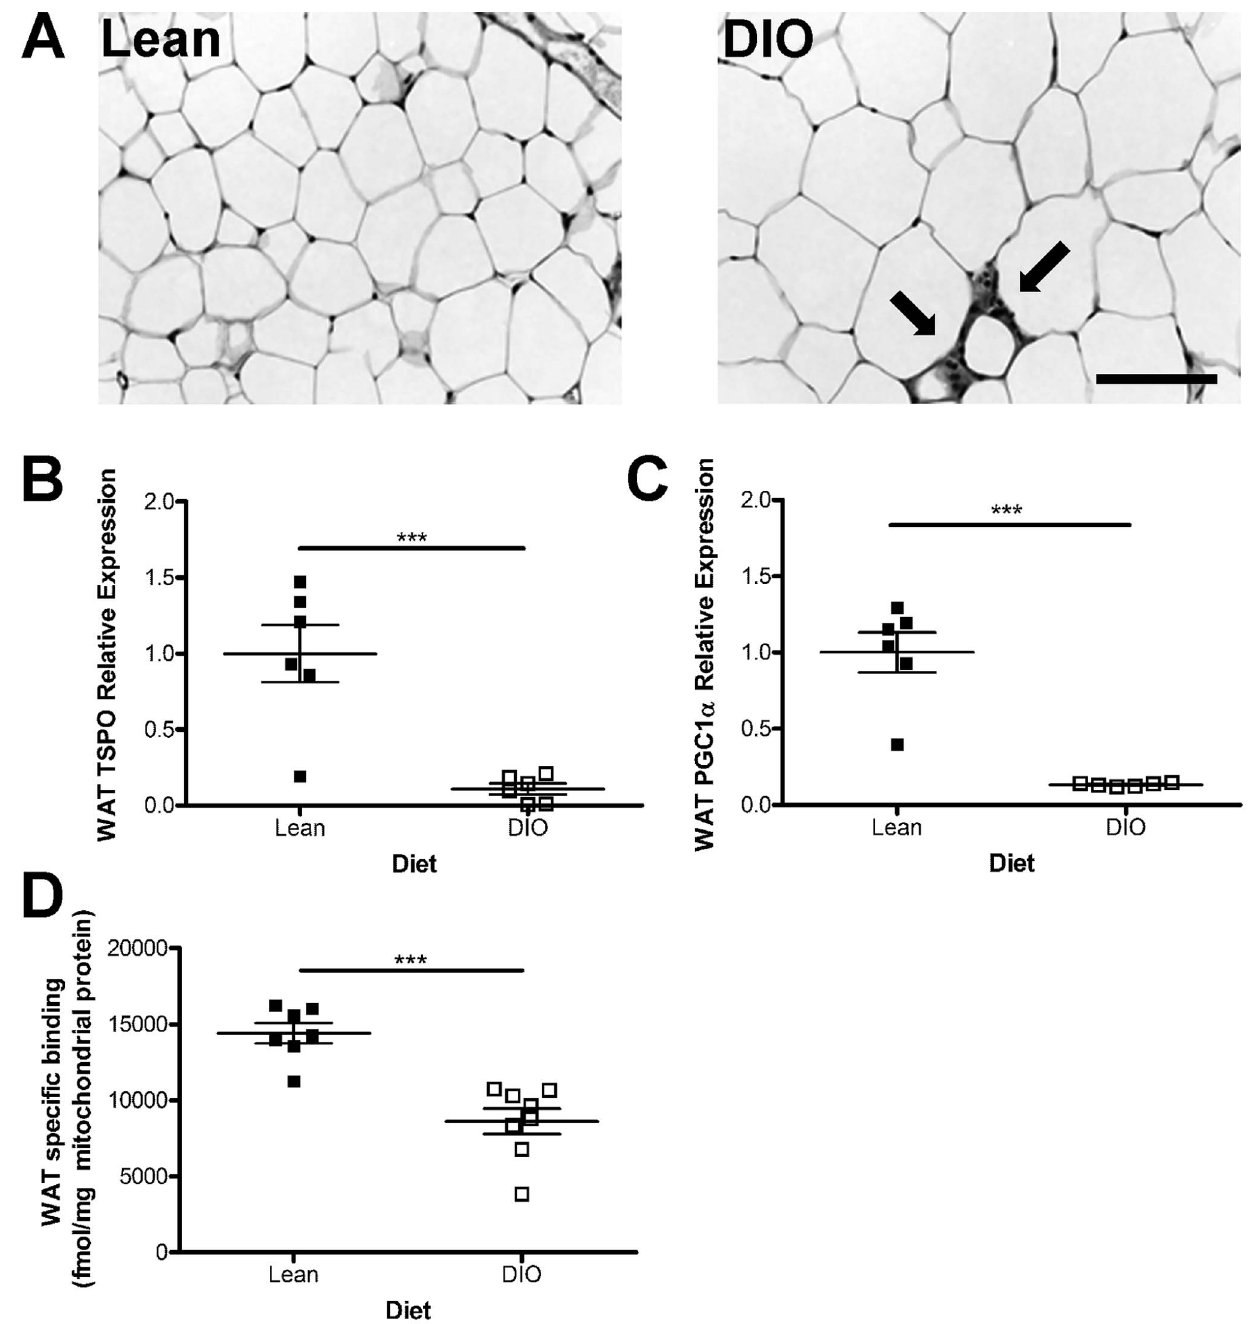
Figure 1. TSPO is down-regulated by diet-induced obesity in white adipose tissue. A) H&E staining of white adipose tissue (WAT) from lean and diet-induced obese (DIO) mice revealed larger, hypertrophic adipocytes in obese tissue surrounded by ‘‘crowning’’ macrophages (indicated by arrows). B) TSPO mRNA was significantly lower in DIO WAT than controls as was PGC1 a (C), a positive control for mitochondrial dysfunction. D) Binding of TSPO ligand 3 H-PK11195 in WAT mitochondrial extracts revealed significantly lower expression of TSPO binding sites in DIO mice as compared to lean controls. Data are expressed as mean 6 standard error. n=6–8. Statistical significance of *** p # 0.001 was determined by unpaired t-test. Scale bar=100 m